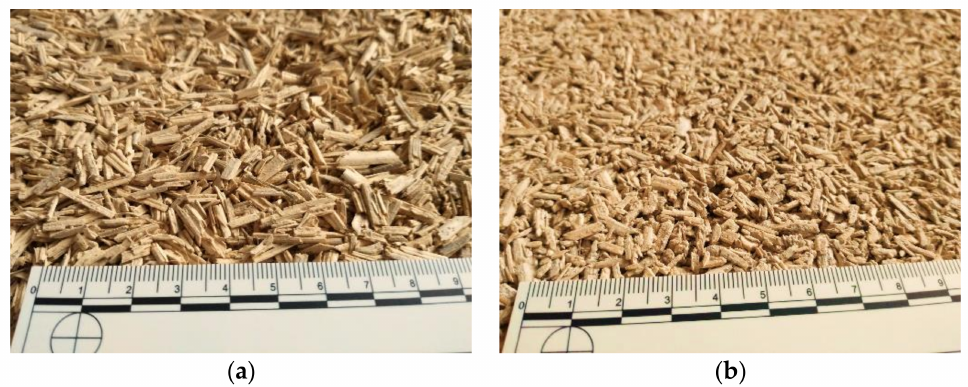
Figure 4. Macroscopic images of samples ( a ) D200 and ( b ) D600. The developed bio-composite composite is dedicated to sustainable buildings, i.e., passive or nearly zero-energy buildings, as it contains natural hemp fibers and a